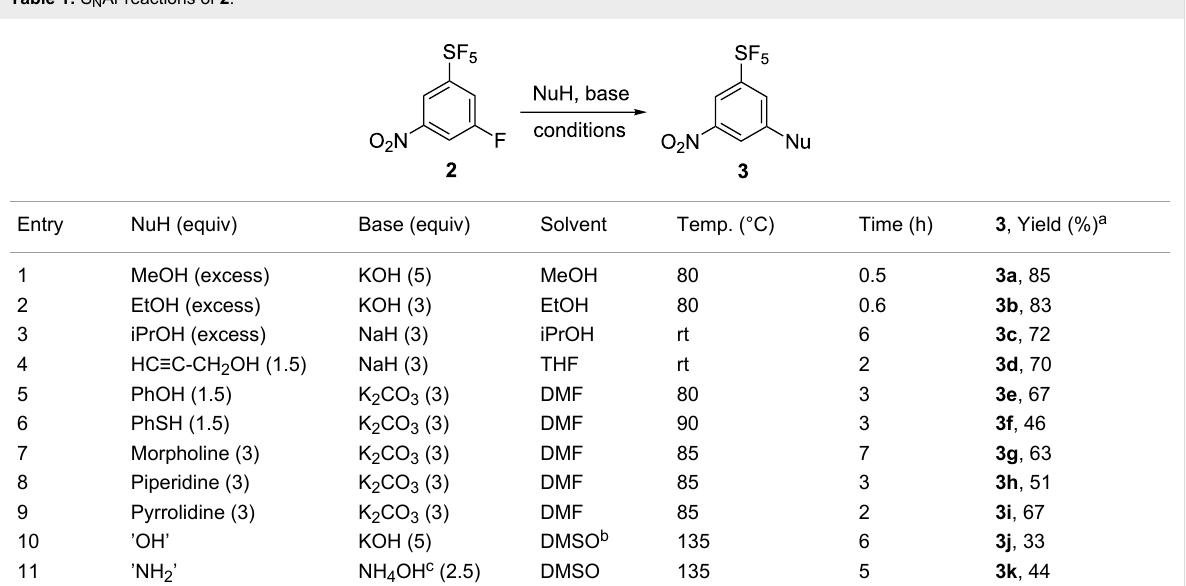
Table 1: S N Ar reactions of 2